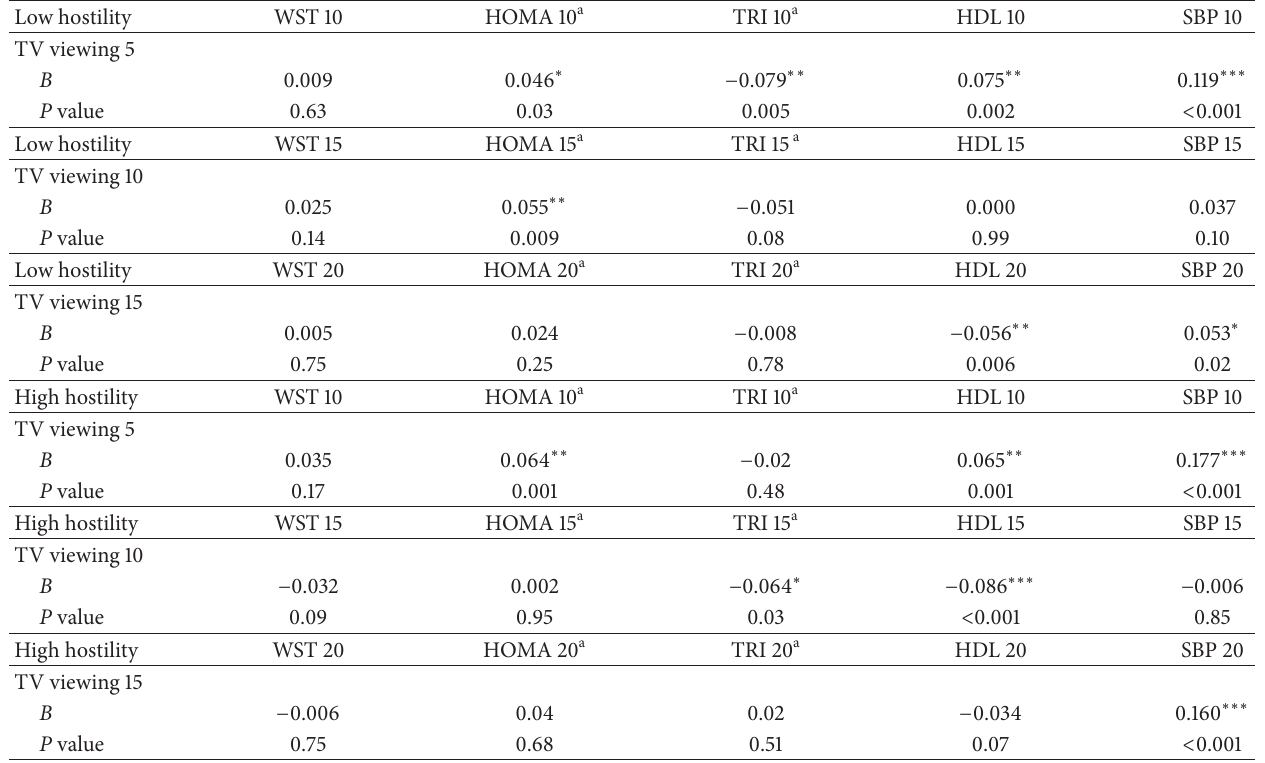
Table 5: Cross-lagged associations from TV viewing to five cardiometabolic risk variables by levels of hostility. Low